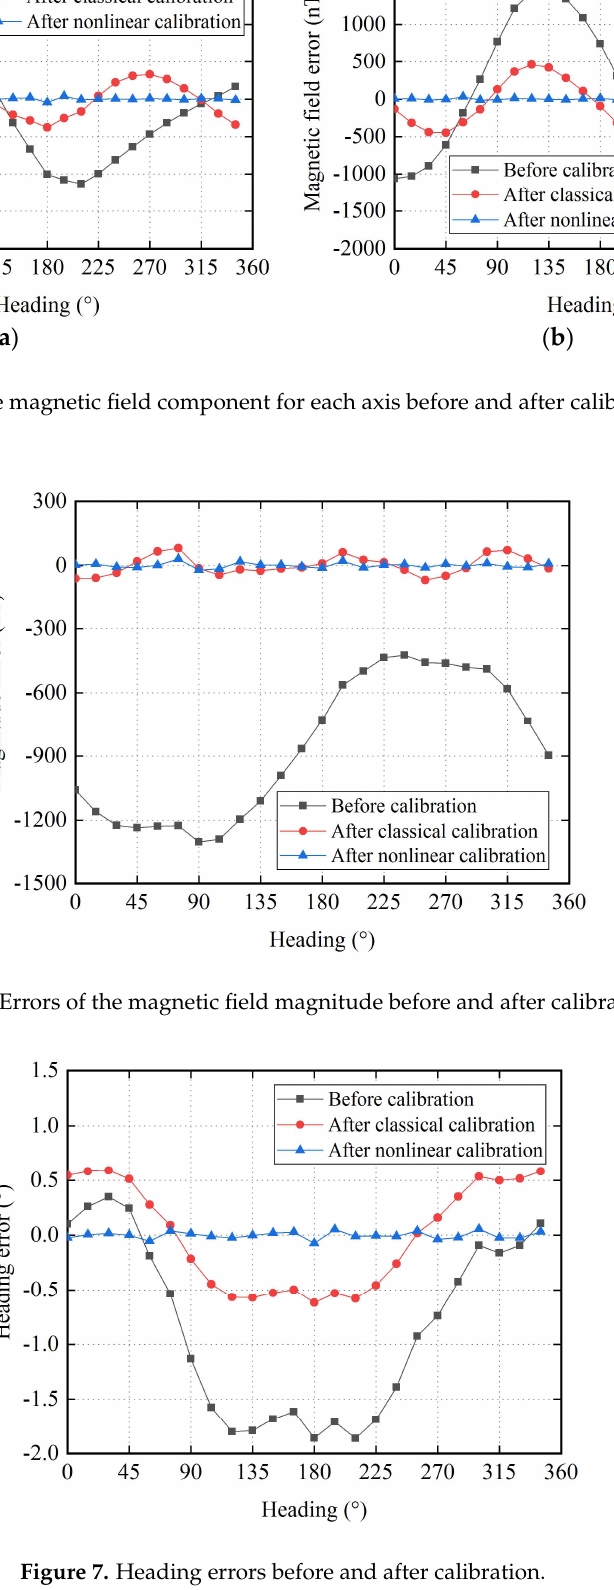
Figure 7. Heading errors before and after calibration.